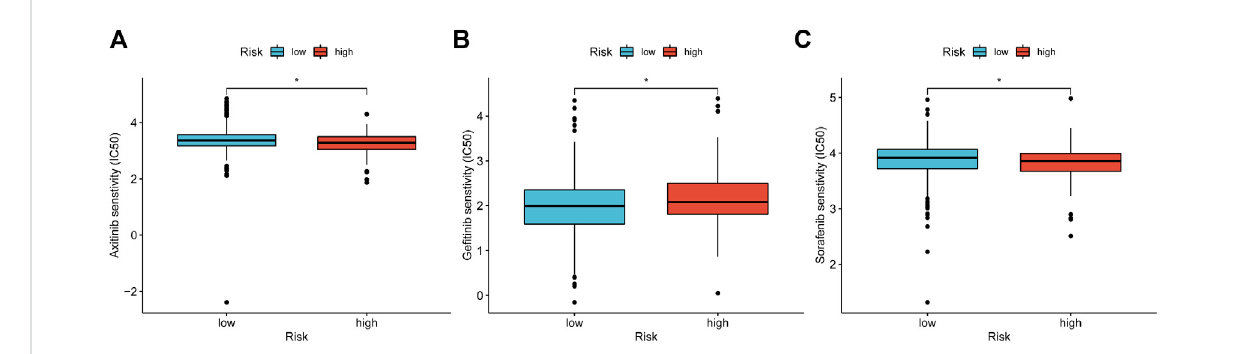
FIGURE 13 Predict potential drug treatment options. (A – I) The IC50 of chemotherapy and targeted drugs based on the TCIA database, including, Axitinib (A) , Ge fi tinib (B) , and Sorafenib (C) .